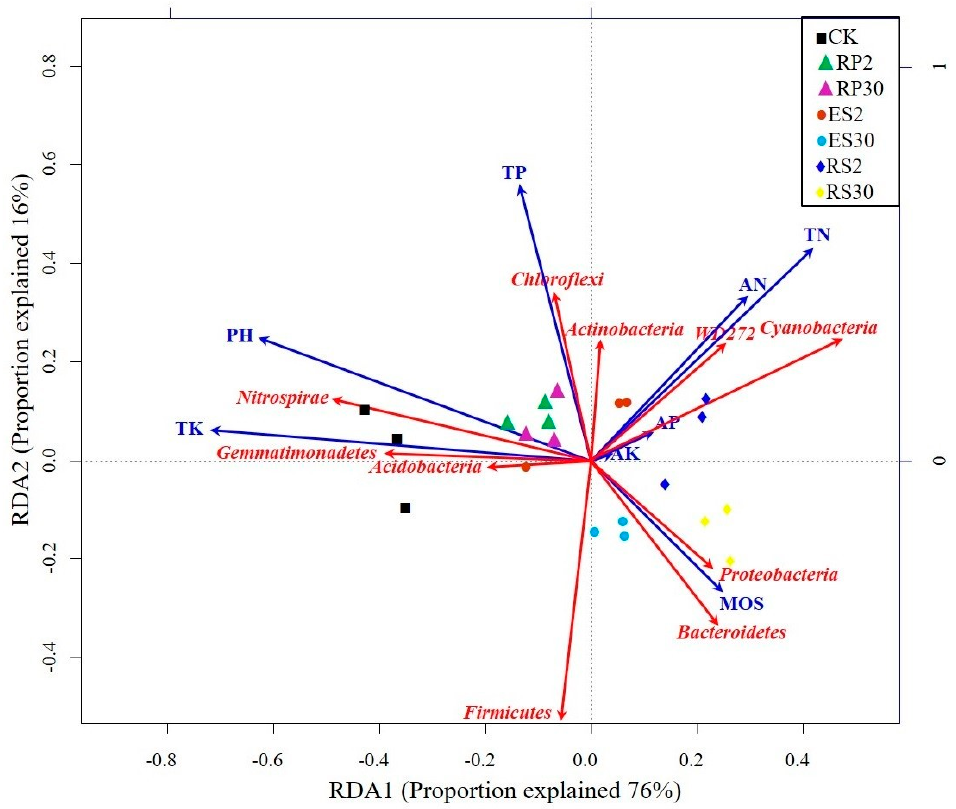
Figure 6. Redundancy analysis ( RDA) Triplot (RDA on a covariance matrix) of the correlation between the most abundant phylum of bacteria and soil physiochemical properties, such as total phosphorus ( TP), total nitrogen (TN), available nitrogen (AN), available potassium (AK), available phosphorus (AP), and pH across the various rhizo-compartments of the different tea plantations of different ages, where rhizosphere RS2 and RS30 are the rhizosphere, RP2 and RP30 are the rhizoplane, and endosphere ES2 and ES30 are the endosphere in two-year and 30-year-old tea gardens, respectively. The arrow length and direction correspond to the variance that can be explained by the environmental and response variables. The direction of an arrow indicates the extent to which the given factor is influenced by each RDA variable. The perpendicular distance between the abundance of bacterial phyla and environmental variable axes in the plot reflects their correlations. The smaller the distance, the stronger the correlation.